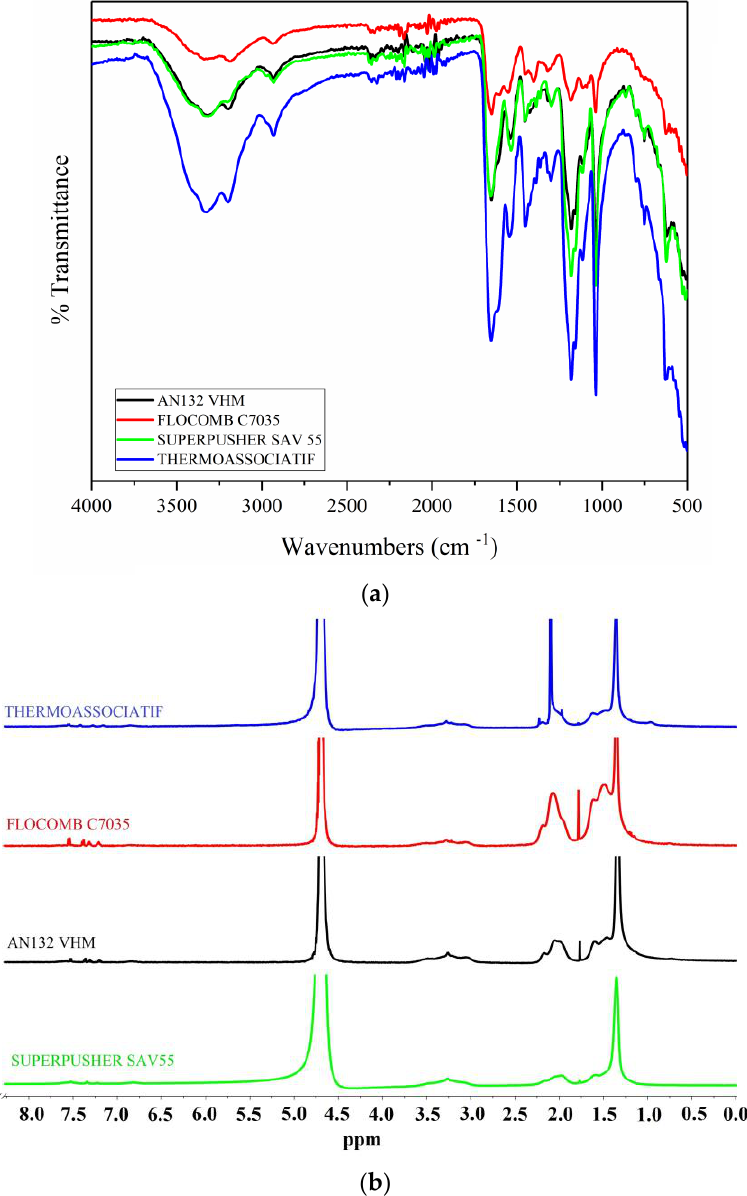
Figure 3. Fourier transform infrared spectroscopy (FTIR) ( a ) and proton nuclear magnetic resonance ( 1 H-NMR) ( b ) spectra of copolymers (FTIR and NMR spectra of THERMOASSOCIATIF polymer extracted from our previous work [4]).